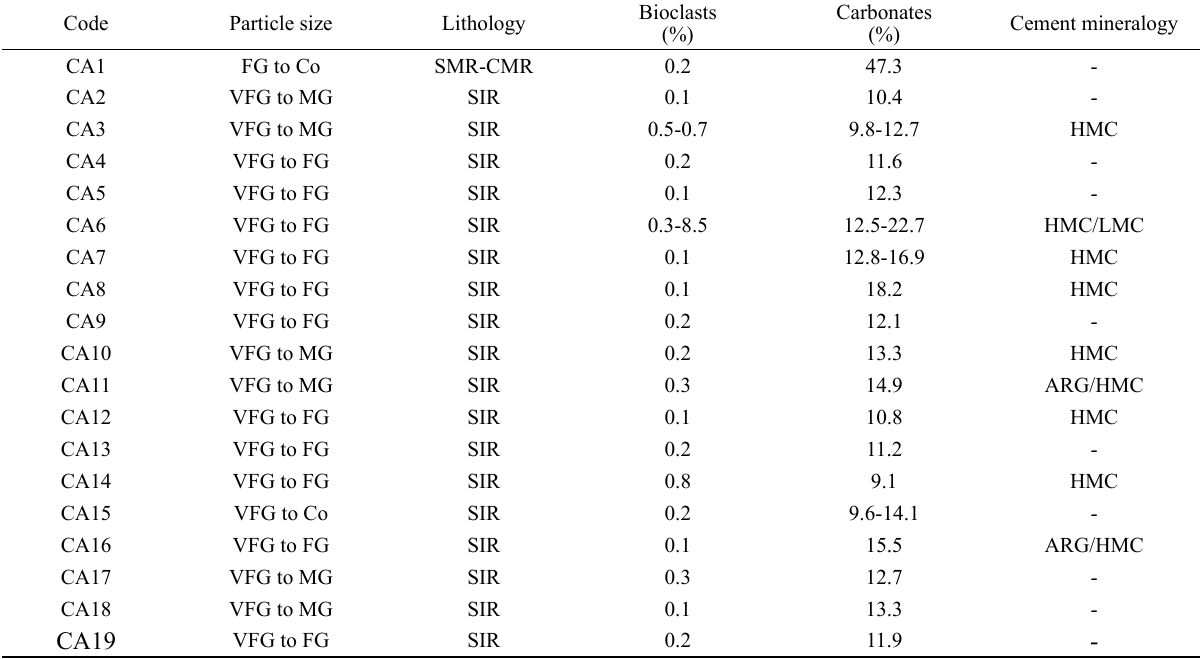
Table 2. – Petrological characteristics of the beachrocks: particle size (VFG, very fine gravel (2-4 mm); FG, fine gravel (4-8 mm); MG, medium gravel (8-16 mm); CG, coarse gravel (16-31 mm); VCG, very coarse gravel (32-64 mm); Co, cobble (64-256 mm)); lithology